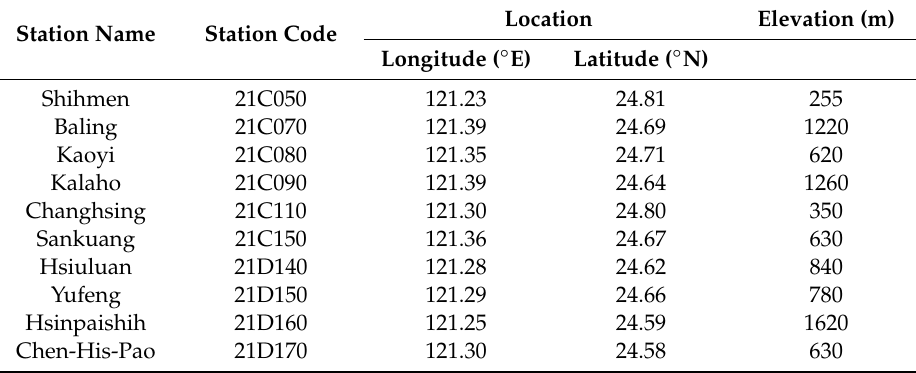
Table 2. Geographic information on the rain gages in the Shihmen Reservoir